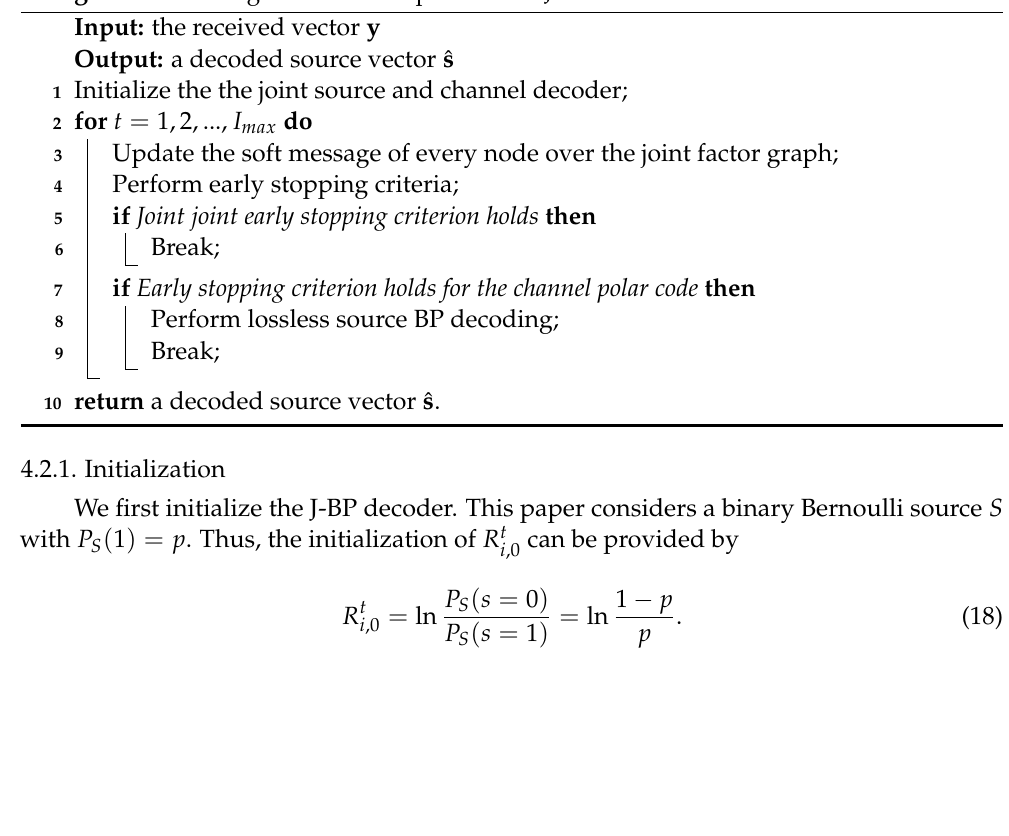
Algorithm 2: A High-Level Description of the Joint Source and Channel